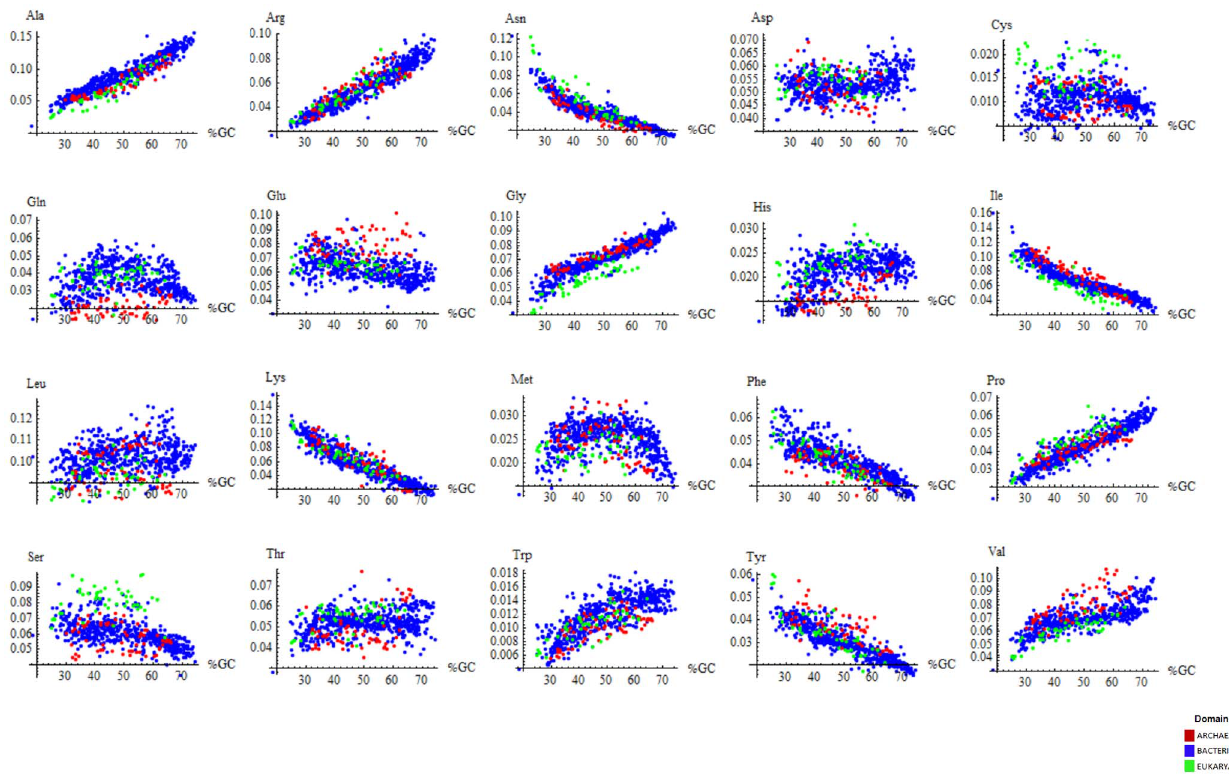
Figure 3. Relative amino acid composition, weighted by d index, of each organism plotted against average GC content.